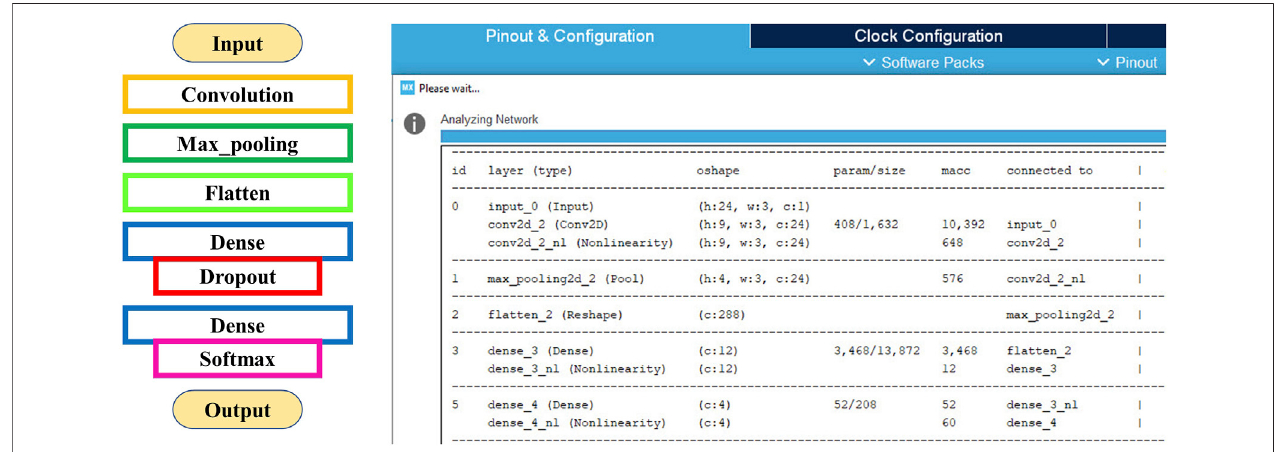
FIGURE 12 | CNN architecture and the overview of the NN